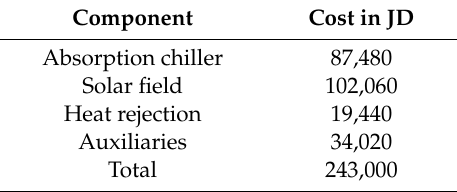
Table 2. Total cost and cost of each of the individual components for the absorption cooling system.